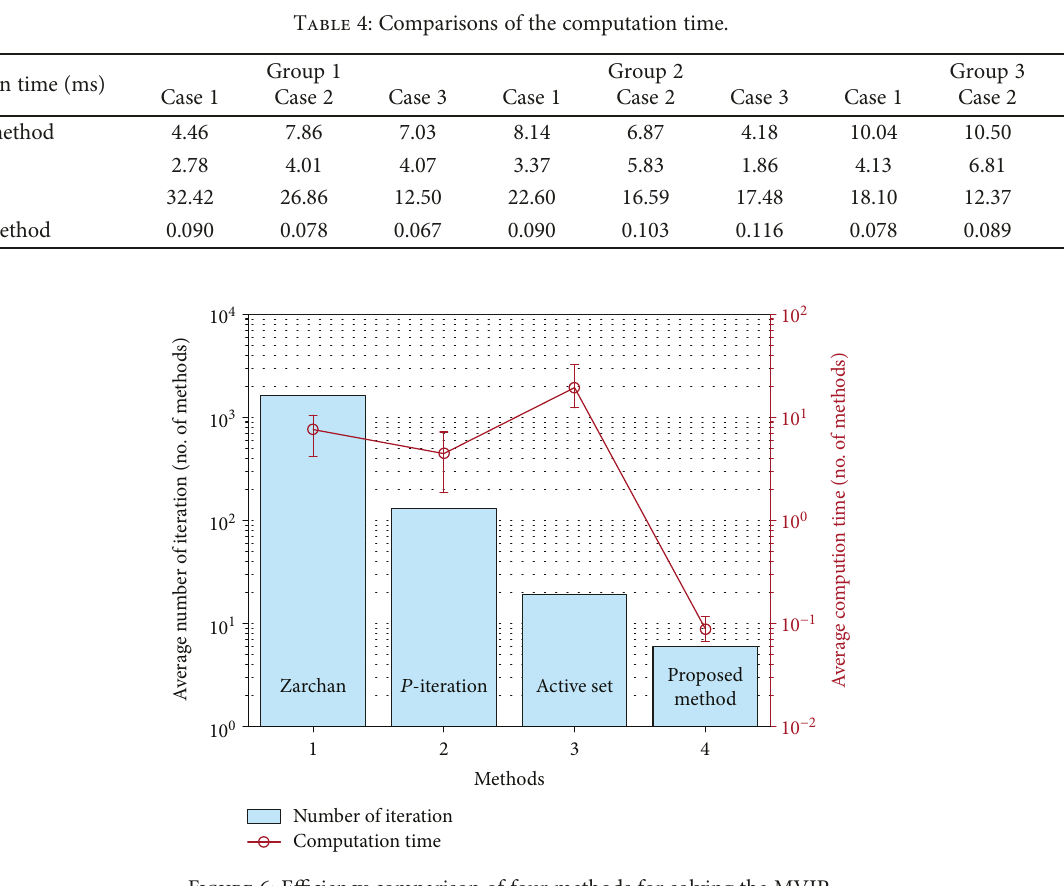
Figure 6: E ffi ciency comparison of four methods for solving the